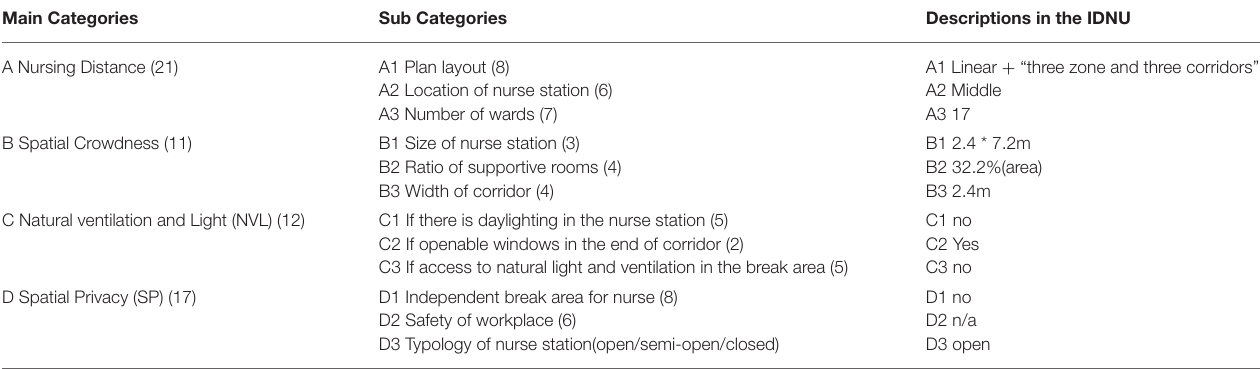
TABLE 2 | The environmental factors relevant to fatigue in infection disease nursing unit.